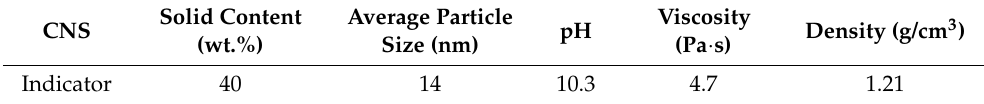
Table 2. Physical characteristics of CNS.